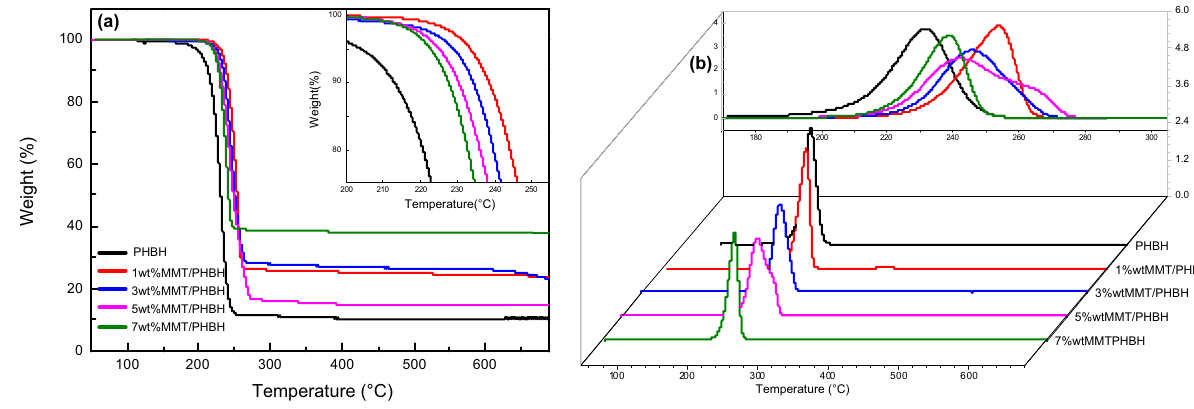
Figure 5: TGA ( a ) and DTG ( b ) curves of PHBH and MMT/PHBH biocomposites.